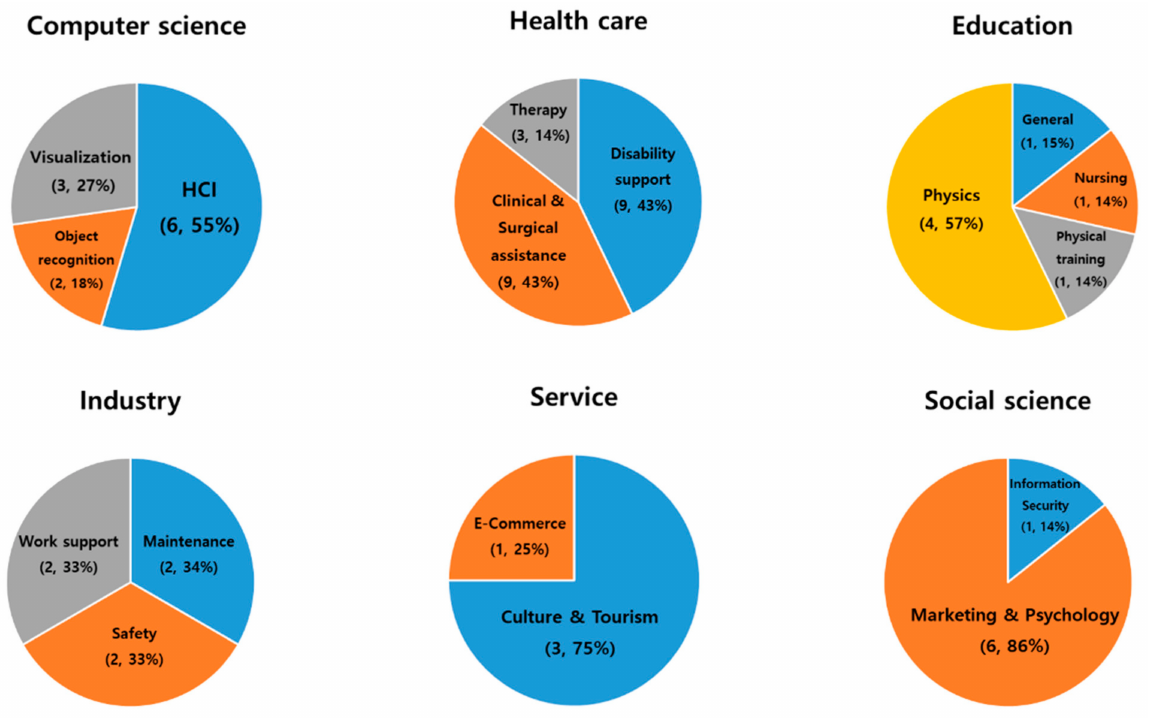
Figure 6. Detailed distribution of smart glass